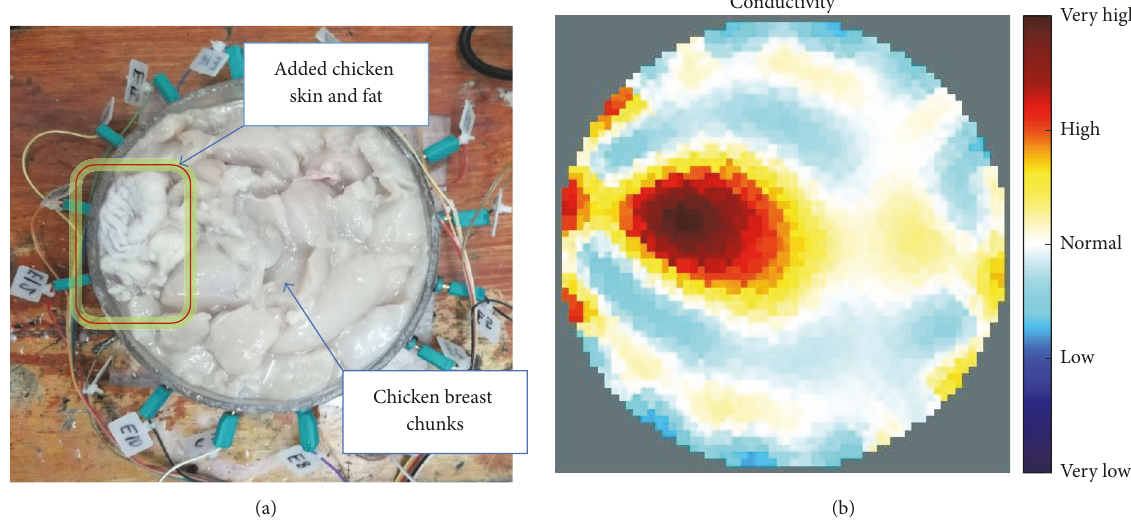
Figure 7: (a) Chicken skin and fat location in the vessel filled with raw chicken breast chunks. (b) 2D reconstructed image of the chicken skin and